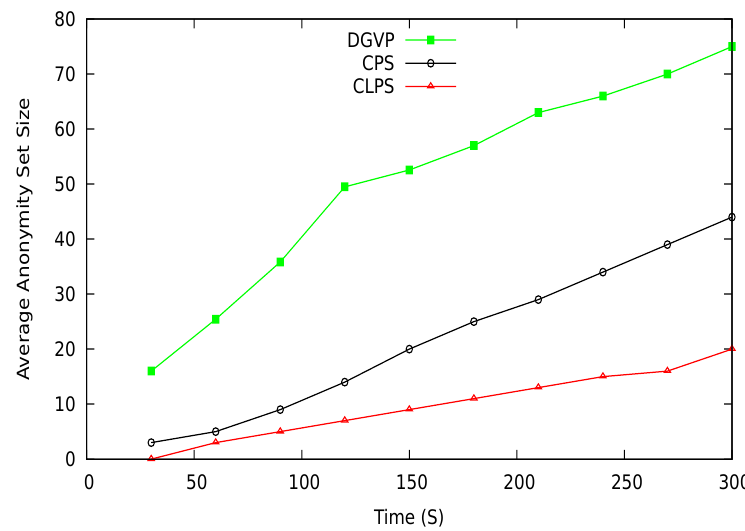
Figure 15. Vehicle anonymization at various time